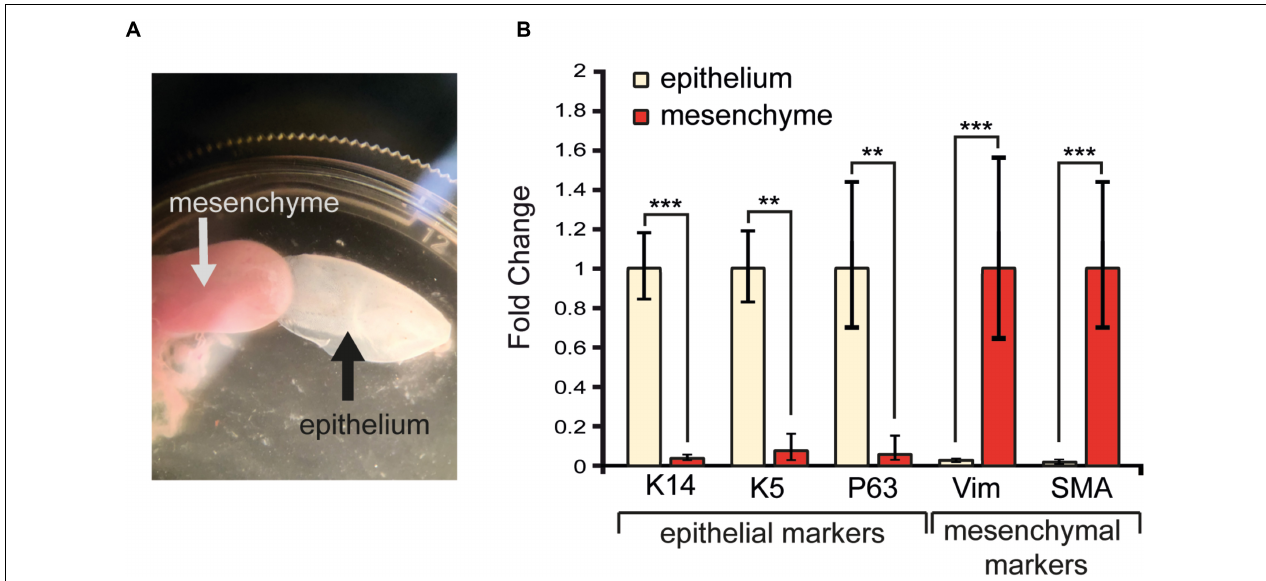
FIGURE 4 | RNA extraction and analysis of transcripts in isolated tongue epithelium and mesenchyme. (A) Isolated mesenchyme and epithelium of the tongue upon enzymatic separation. (B) Gene expression levels of epithelial ( Keratin14 , Keratin5 , P63 ) and mesenchymal ( Vimentin, SMA ) molecular markers upon tissue isolation. ∗∗ p ≤ 0.01; ∗∗∗ p ≤